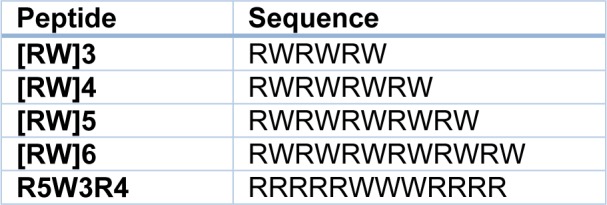
Peptide sequences